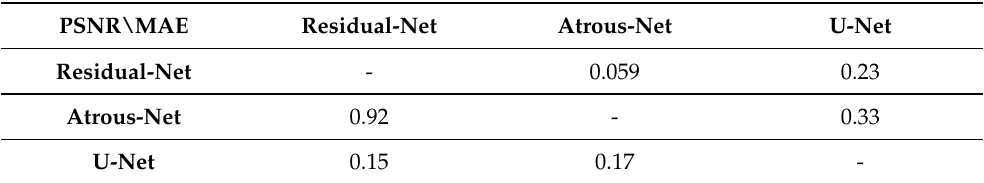
Table 29. MAE and PSNR p -values for 3D Pelvis. p -values of paired Student’s t -test for MAE and PSNR results with 3D architectures with the pelvis dataset.